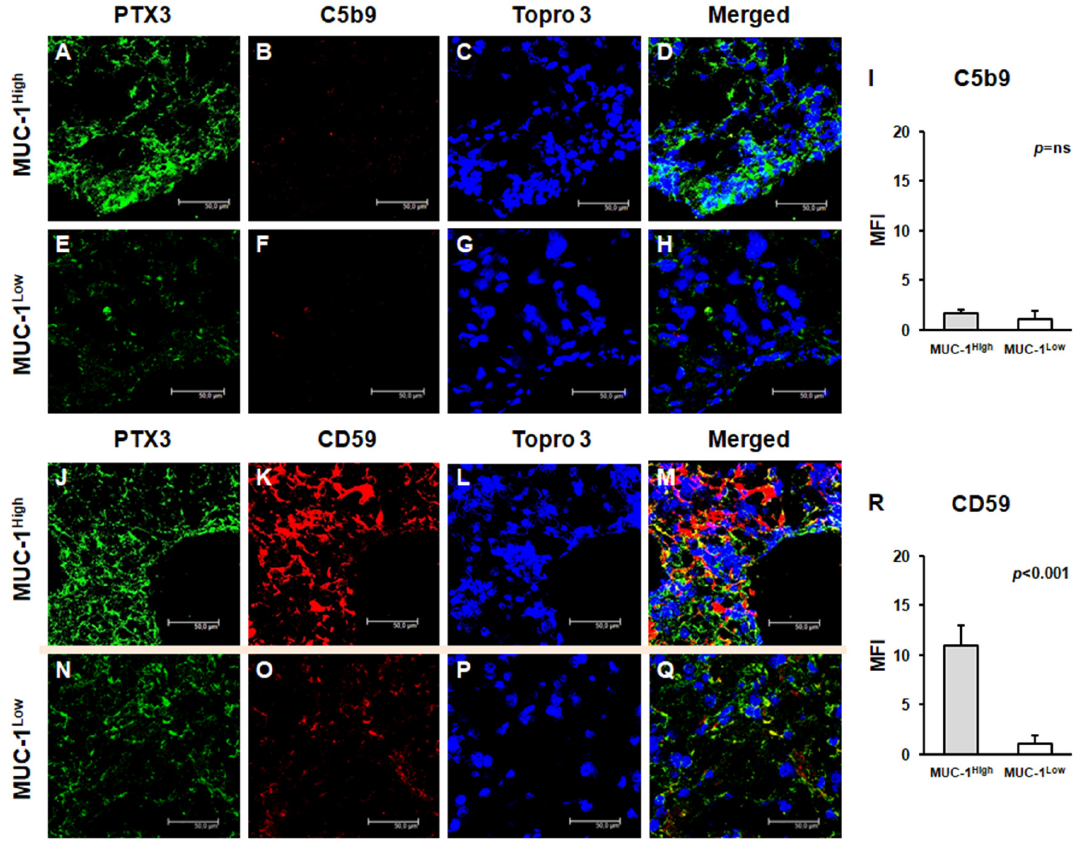
Figure 3. Expression of complement system factors’ C5b-9 ( A – H ) and CD59 ( J – Q ) and their colocal- ization with PTX3 in neoplastic renal tissues from MUC1 H ccRCC and MUC1 L ccRCC by confocal microscopy and quantification of specific fluorescence ( I , R ).